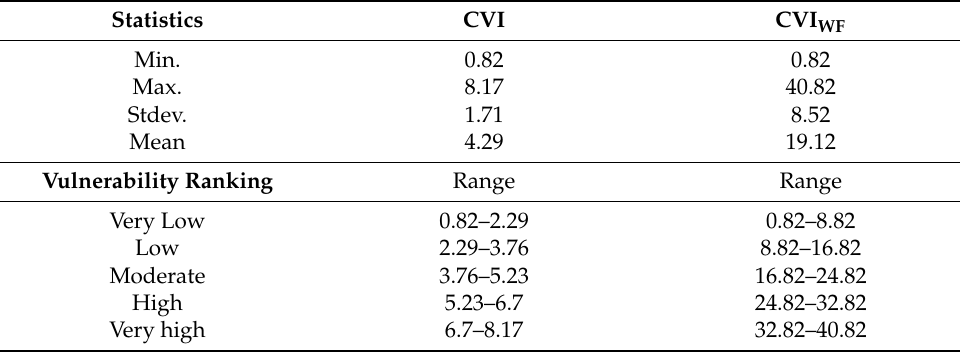
Table 6. Statistics data of the CVI and CVI WF and ranges of the vulnerability classes.